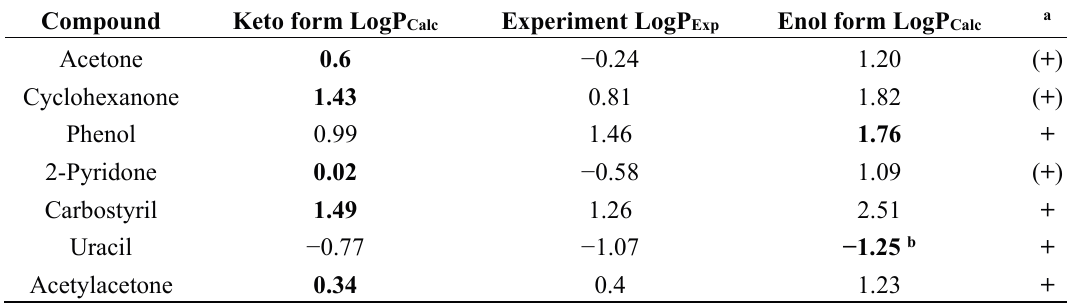
Table 10. LogP of Ketones and Lactams.